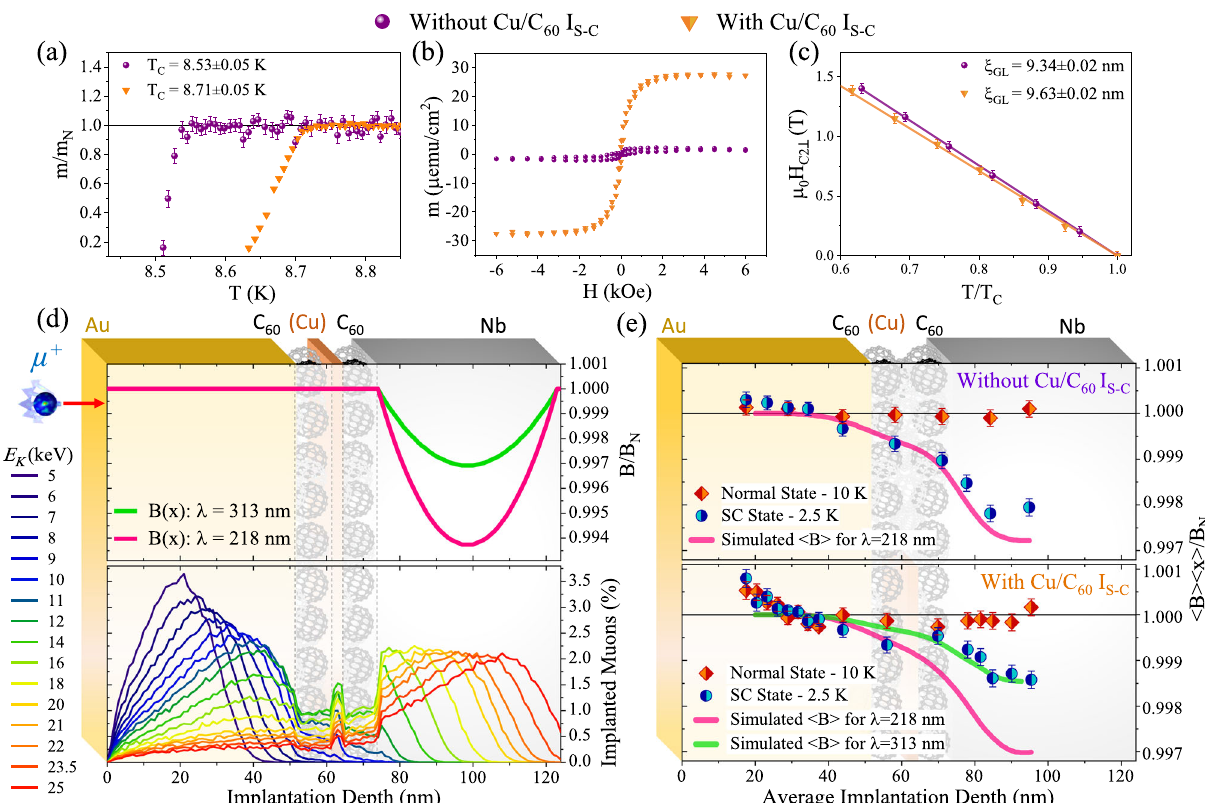
Fig. 3 Anomalous Meissner signal measured by low-energy muon spin rotation in Single-Probe samples. a Moment vs. temperature scans show that the onset of Meissner screening in the two samples occurs at similarly high temperatures (>8.5 K). b Magnetic hysteresis loops measured at 300 K, showing a moment of 27 ± 1 μ emu cm − 2 (with Cu/C 60 interfaces; orange triangles) and 2 ± 1 μ emu cm − 2 (without; purple dots). c The temperature dependence of the out of plane critical fi eld, H c2 ? T ð Þ , for the two heterostructures gives similar Ginzberg-Landau coherence lengths. d Simulated magnetic fl ux pro fi les, < B> < x >, where the green and pink functions model the expected fl ux expulsion for London penetration lengths of 313 (green line) and 218 nm (pink line), respectively. The implantation distributions, according to the muon stopping depths for all energies used are also shown. e The average local magnetic fl ux, < B >, measured at 2.5 K (orange diamonds) and 10 K (blue dots) and normalised to the fl ux density in the niobium layer at 10 K, B N . The London model gives penetration lengths of 313 nm (with Cu/C 60 ) and 218 nm (without). Error bars are statistical variations over 5 million muon decay